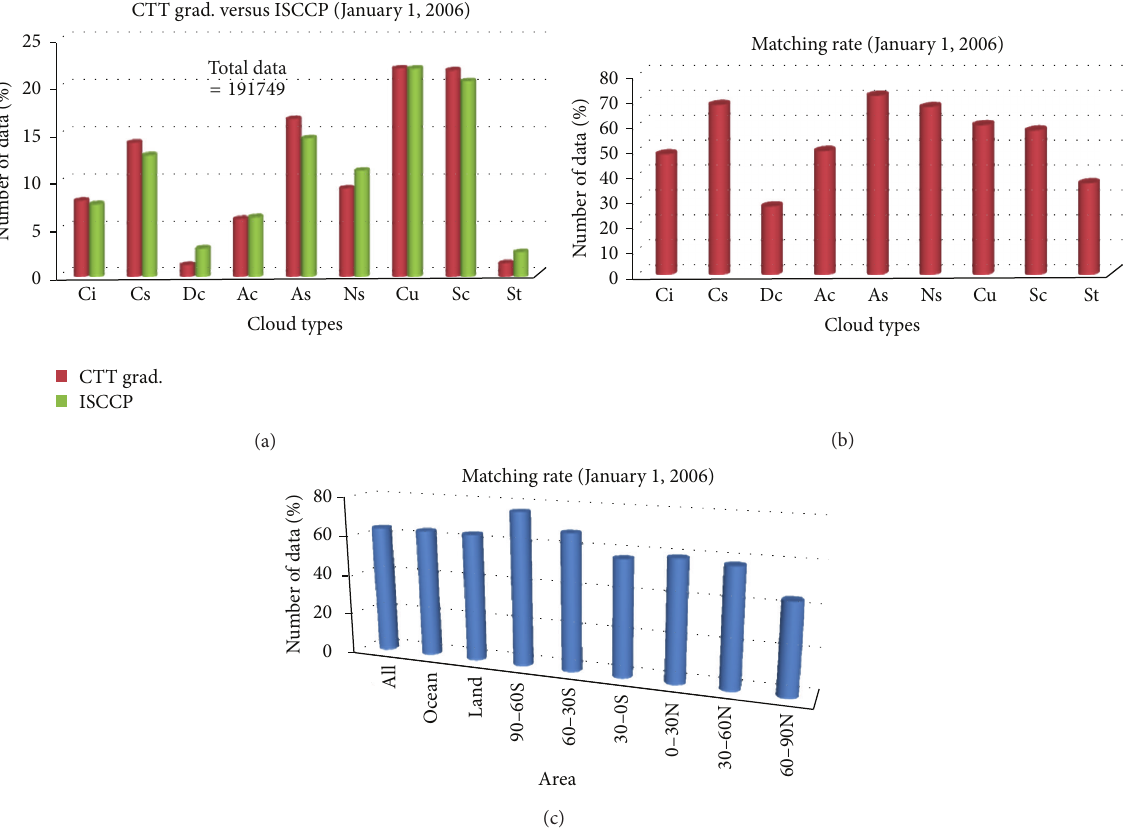
Figure 6: Comparative histograms for January 1, 2006, of the cloud type frequency obtained from the cloud top temperature (CTT) gradient classification a, b and the ISCCP classification method (a) the matching rate for each cloud type (b) and each region (c). 1—Ci: cirrus, 2—Cs: cirrostratus, 3—Dc: deep convection, 4—Ac: altocumulus, 5—As: altostratus, 6—Ns: nimbostratus, 7—Cu: cumulus, 8—Sc: stratocumulus, and 9—St: stratus. All: all